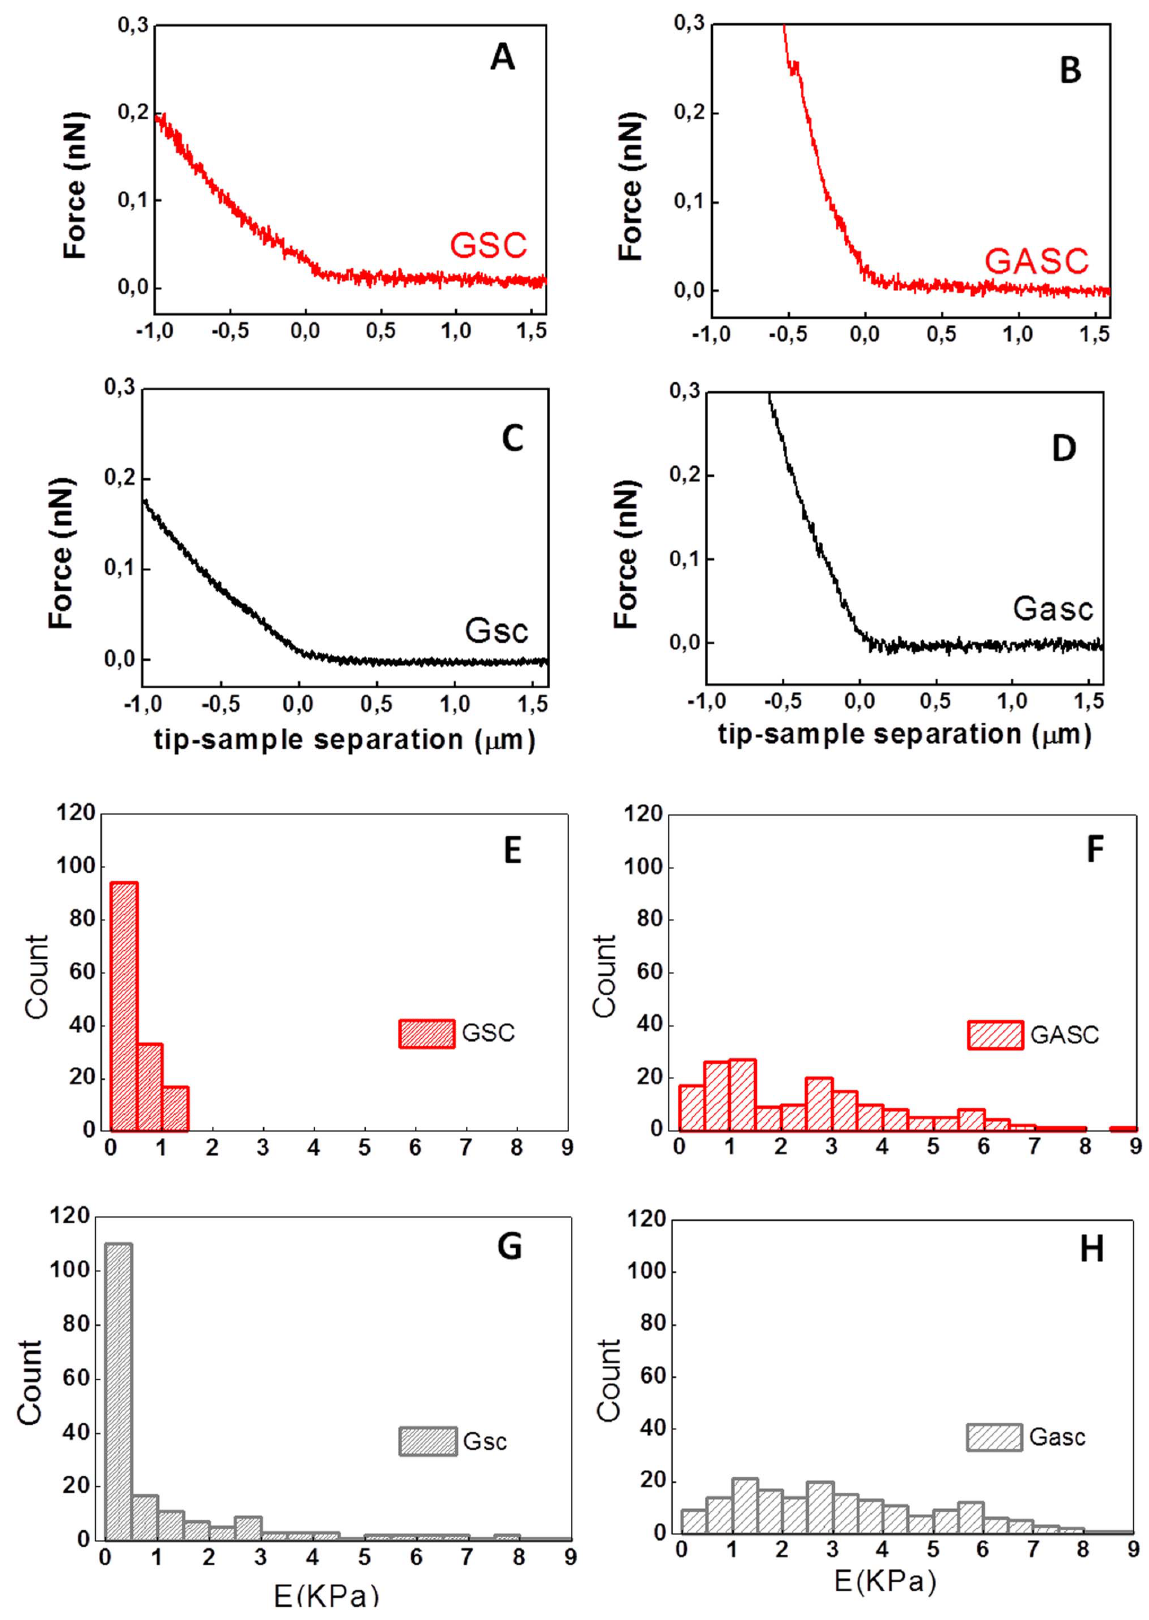
Figure 2. AFM indentation measurements and analysis of each cell subpopulation. ( A–D ) Examples of F-D approaching curves converted into a dependence of load force versus indentations for each cell populations. ( E–H ) Young’s modulus distribution obtained for each cell population.